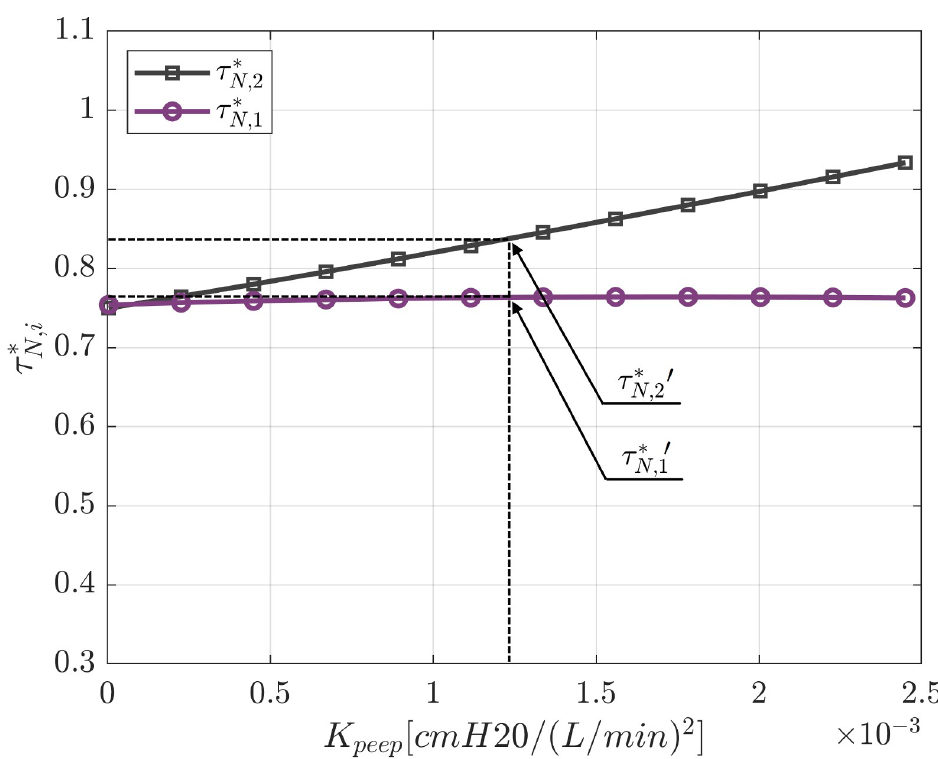
Fig 9. Influence of in-line PEEP valve resistance on characteristic times for symmetric conditions ( PEEP 1 = PEEP 2 = 5 cm H 2 0, DP 1 = DP 2 = 15 cm H 2 0, R 1 = R 2 = 5 cm H 2 0 (L/s) − 1 , C 1 = C 2 = 35 ml (cm H 2 0) − 1 ), and R (L/s) − 1